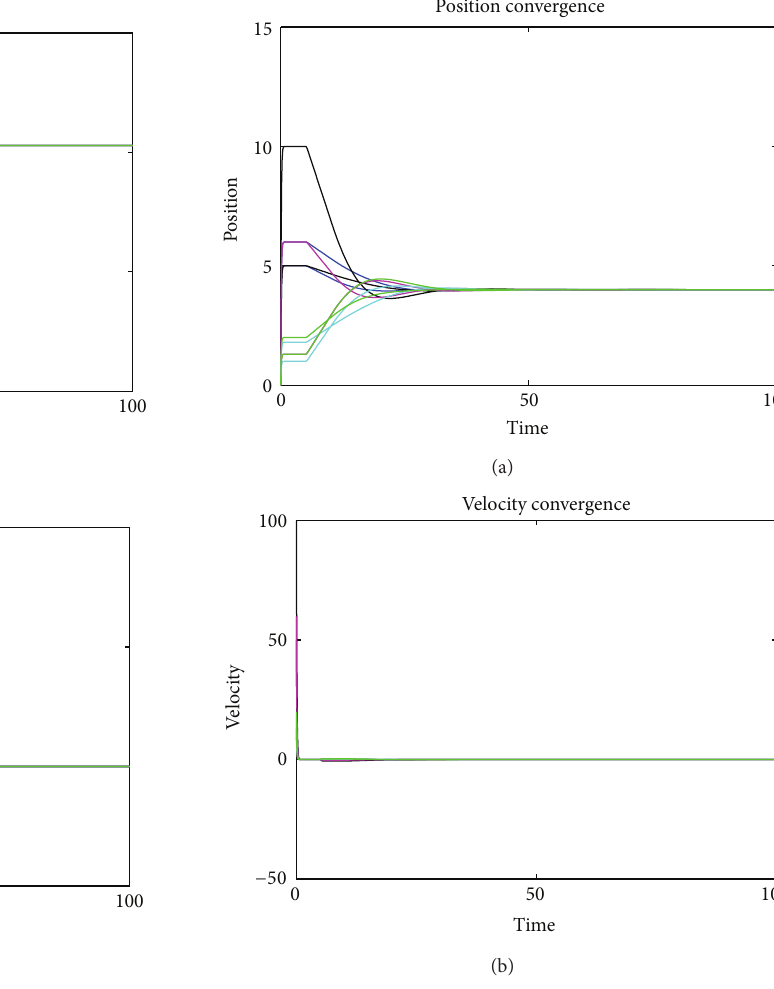
Figure 2: The consensus in system (1) with the symmetric topology as 𝜏 = 0.1 .